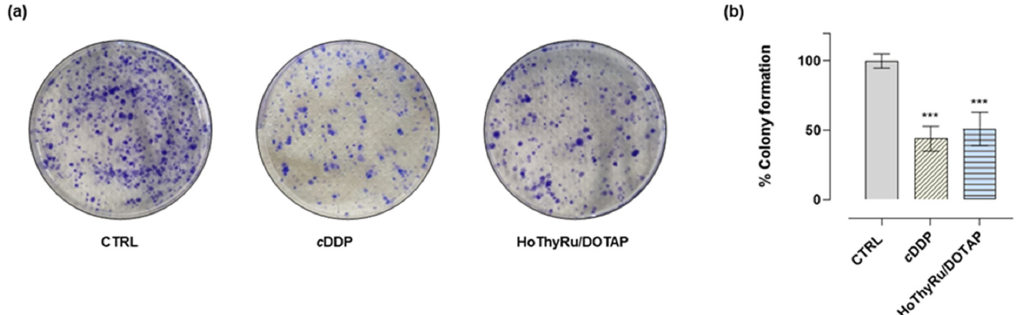
Figure 2. Colony formation assay in the experimental model of TNBC. ( a ) Representative images of MDA-MB-231 cells stained with 0.5% crystal violet at the experiment endpoint. Cells were treated or not (Ctrl) with IC 50 concentrations of HoThyRu/DOTAP and cisplatin ( c DDP), as indicated in the experimental section. c DDP is used as a cytotoxic reference drug. ( b ) Quantification by bar graphs of the cell colonies formation after the indicated treatments. *** p < 0.001 vs. untreated cells (Ctrl).